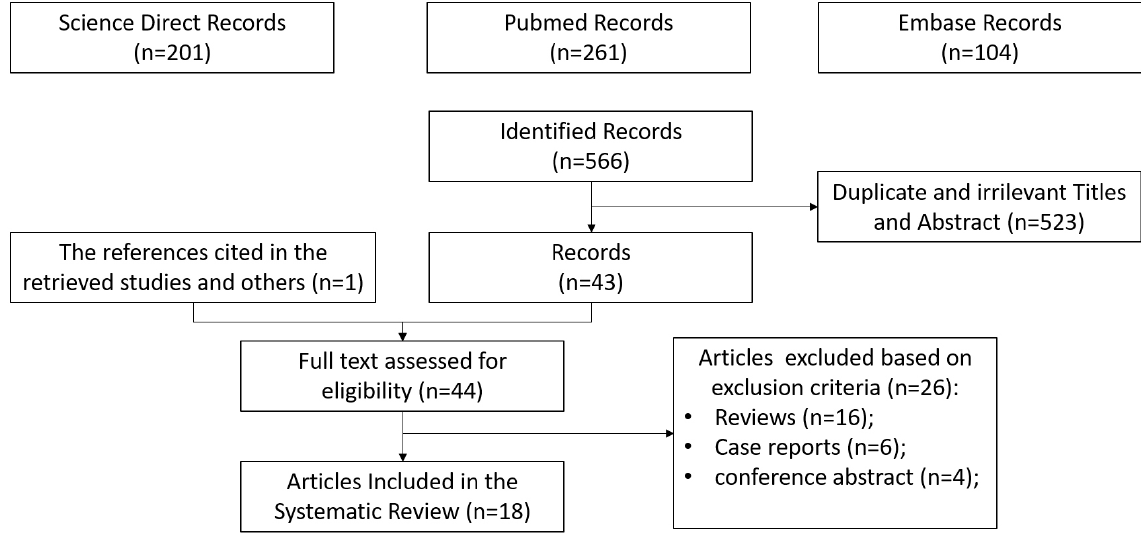
Figure 1. PRISMA flow chart of the eligible studies after identification and screening of